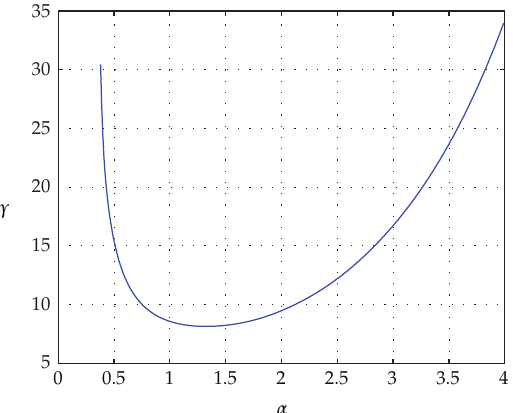
Figure 1: The local optimal bound of γ